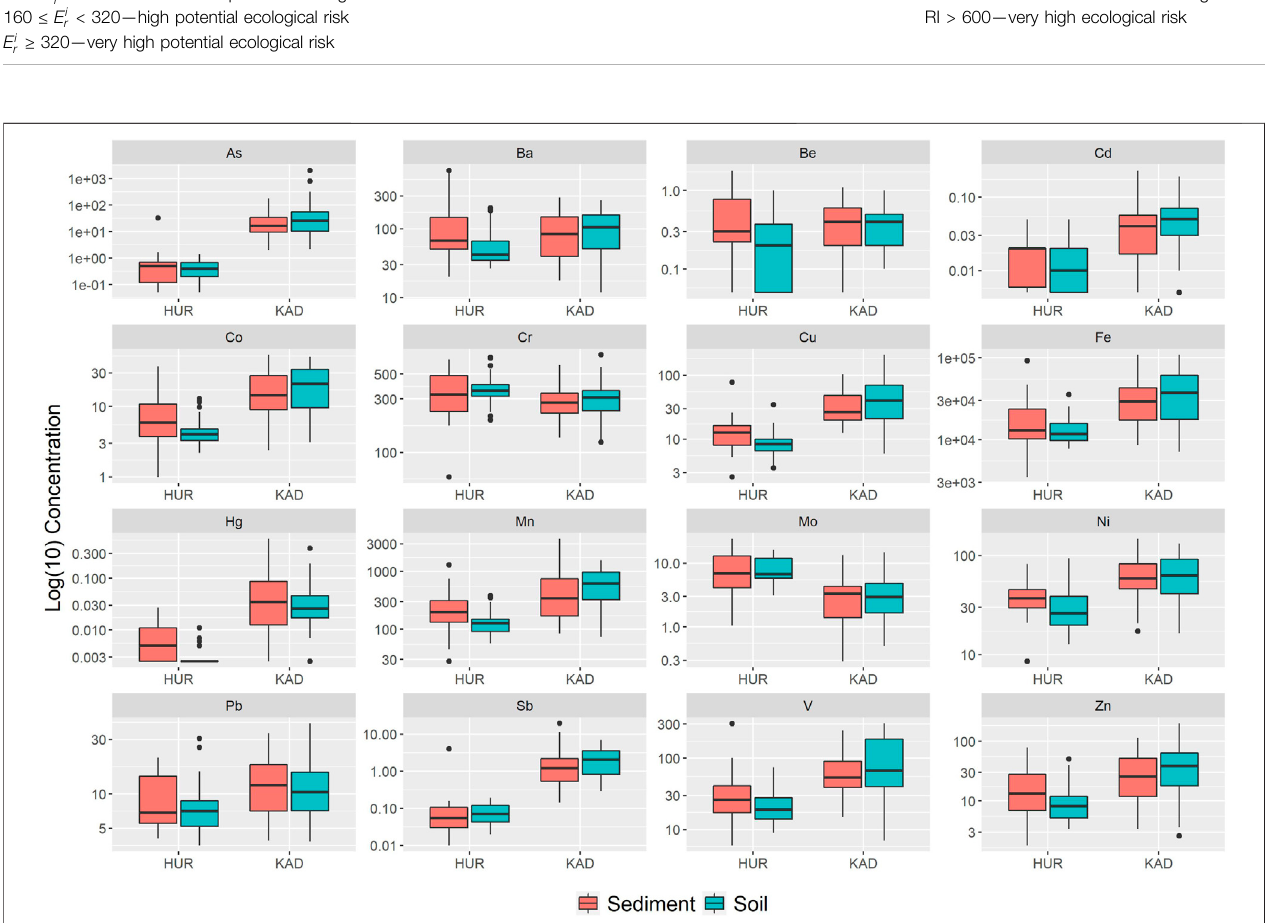
FIGURE 3 | Log transformed concentrations of potentially toxic elements in surface soil and stream sediment samples of the KAD and HUR domains.